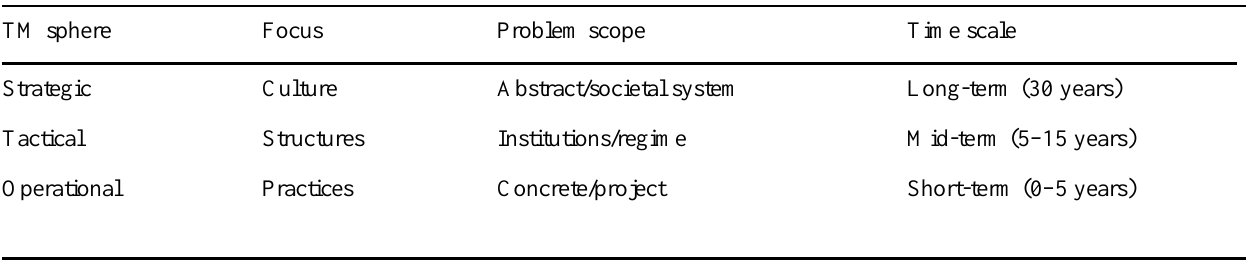
Table 2. . Management spheres distinguished within transition management literature. Between the spheres, management activities differ in focus, scope, and time scale, based on (Loorbach and van Raak